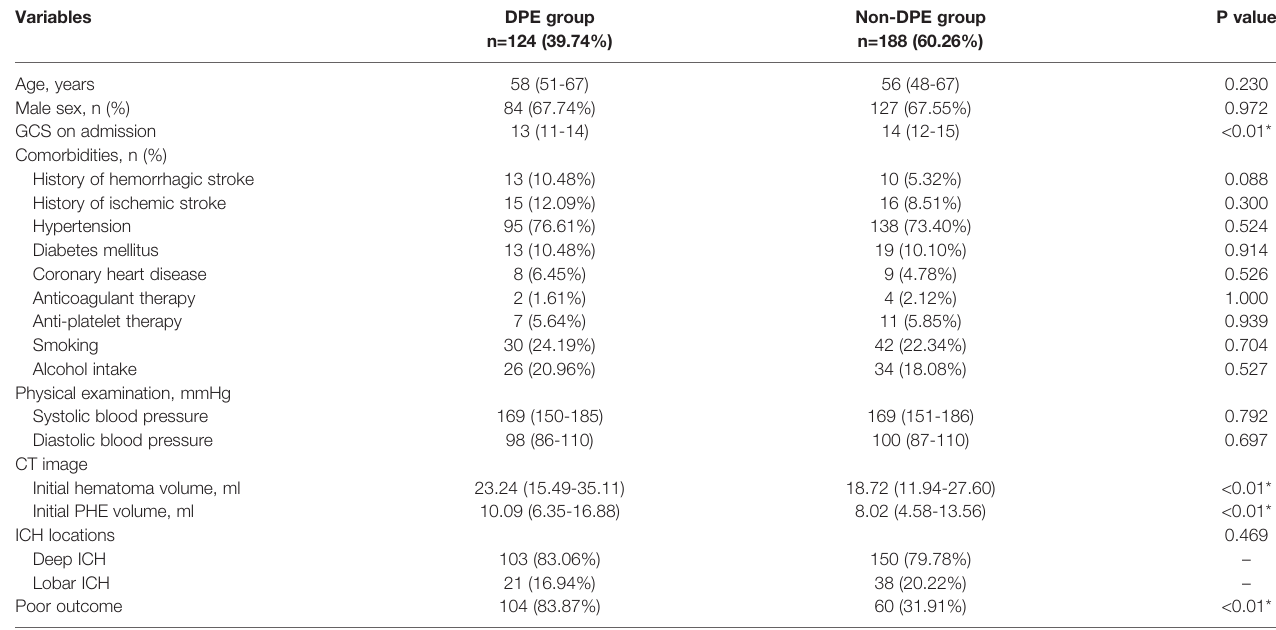
TABLE 3 | Baseline Demographic and Clinical Characteristics of Patients in DPE Group and The Non-DPE Group. Variables DPE